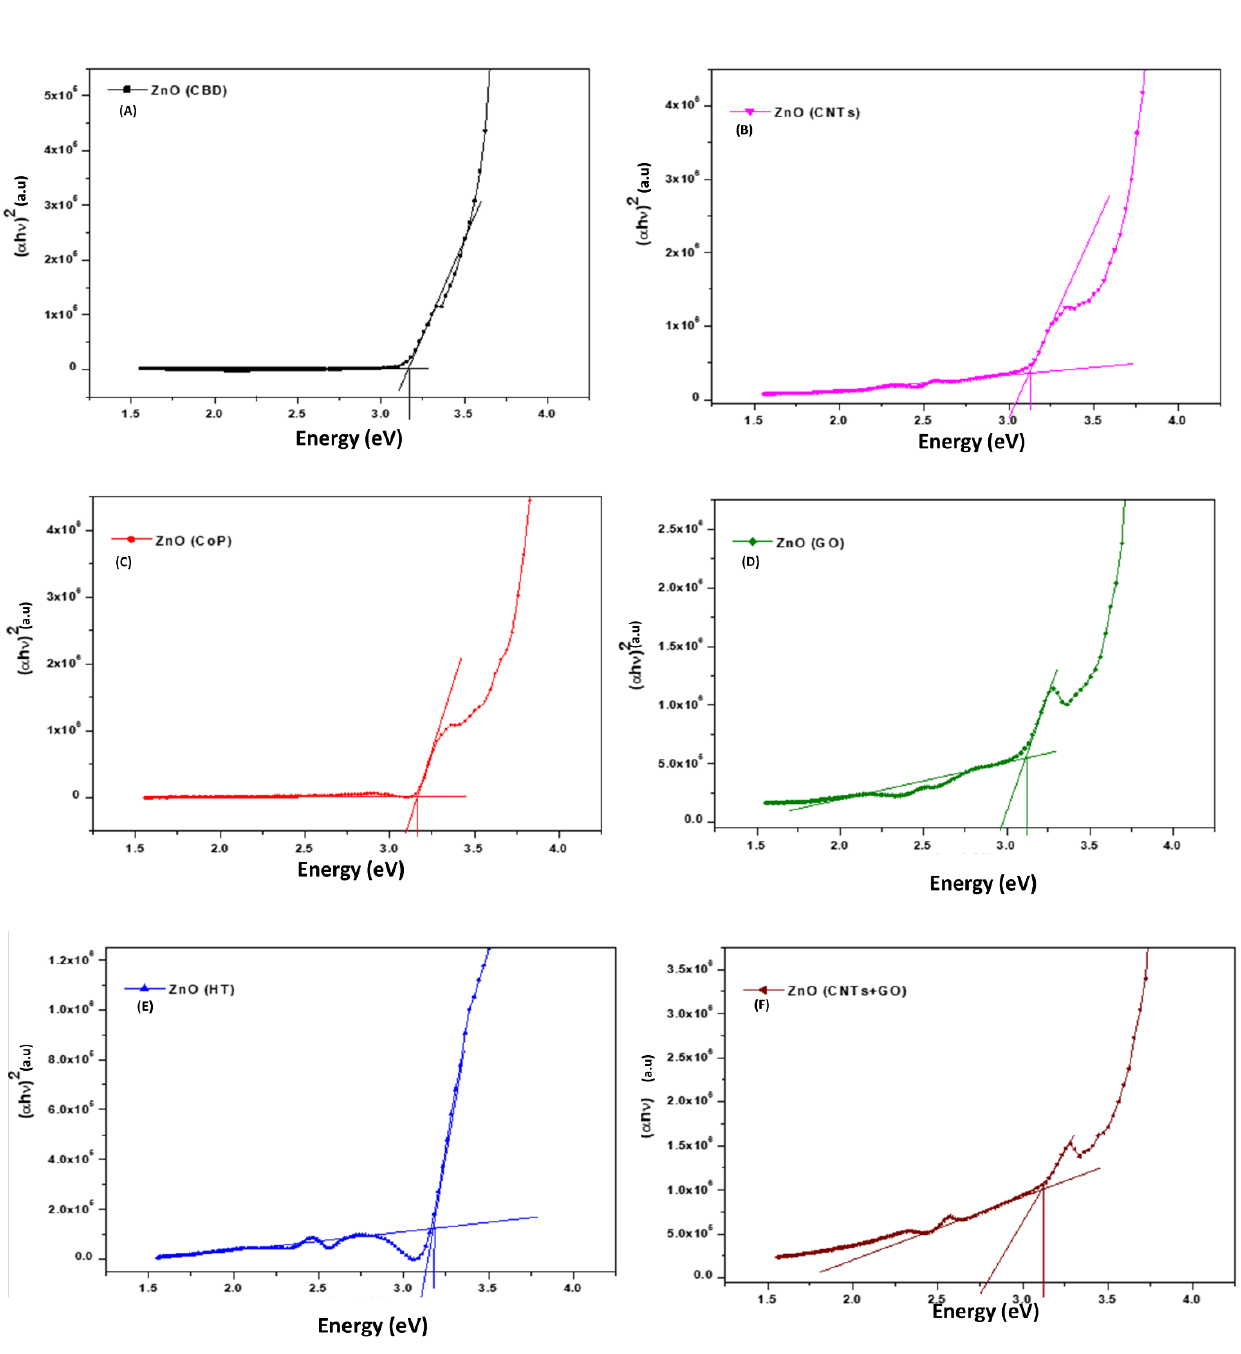
Figure 6. Band gap extraction for the ZnO nanostructures (( A )—CBD, ( B )—CNTs, ( C )—CoPs,